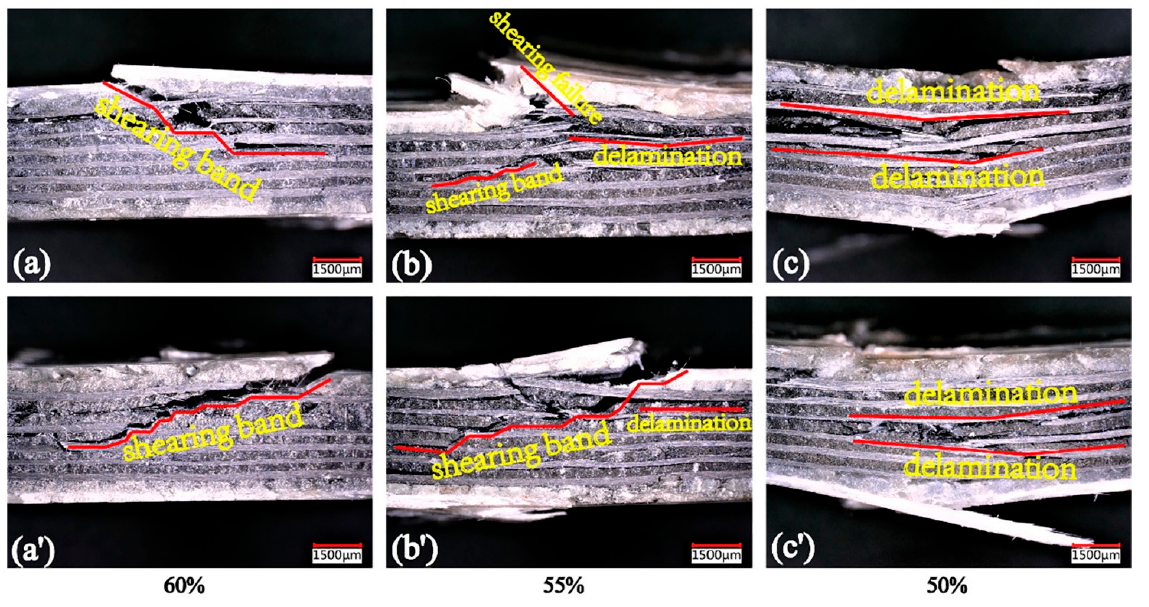
Figure 41. Exemplary fatigue failure mechanism of a laminated hybrid PMC structure under different stress levels: ( a , a’ ) 60%; ( b , b’ ) 55%; ( c , c’ ) 50%, adapted with permission from Ref. [127]. Copyright © 2019 Elsevier Ltd.